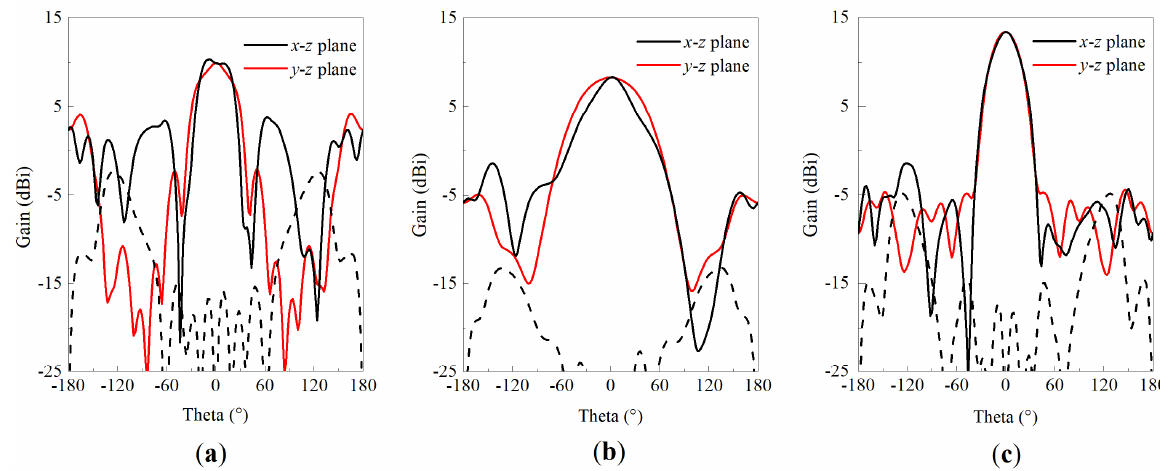
Figure 4. Radiation patterns at 24 GHz: ( a ) Dielectric rod antenna using a planar SIW feed; ( b ) Slot and monopole feeder without dielectric rod; ( c ) Dielectric rod antenna using a SIW feed with a pair of parasitic monopoles.